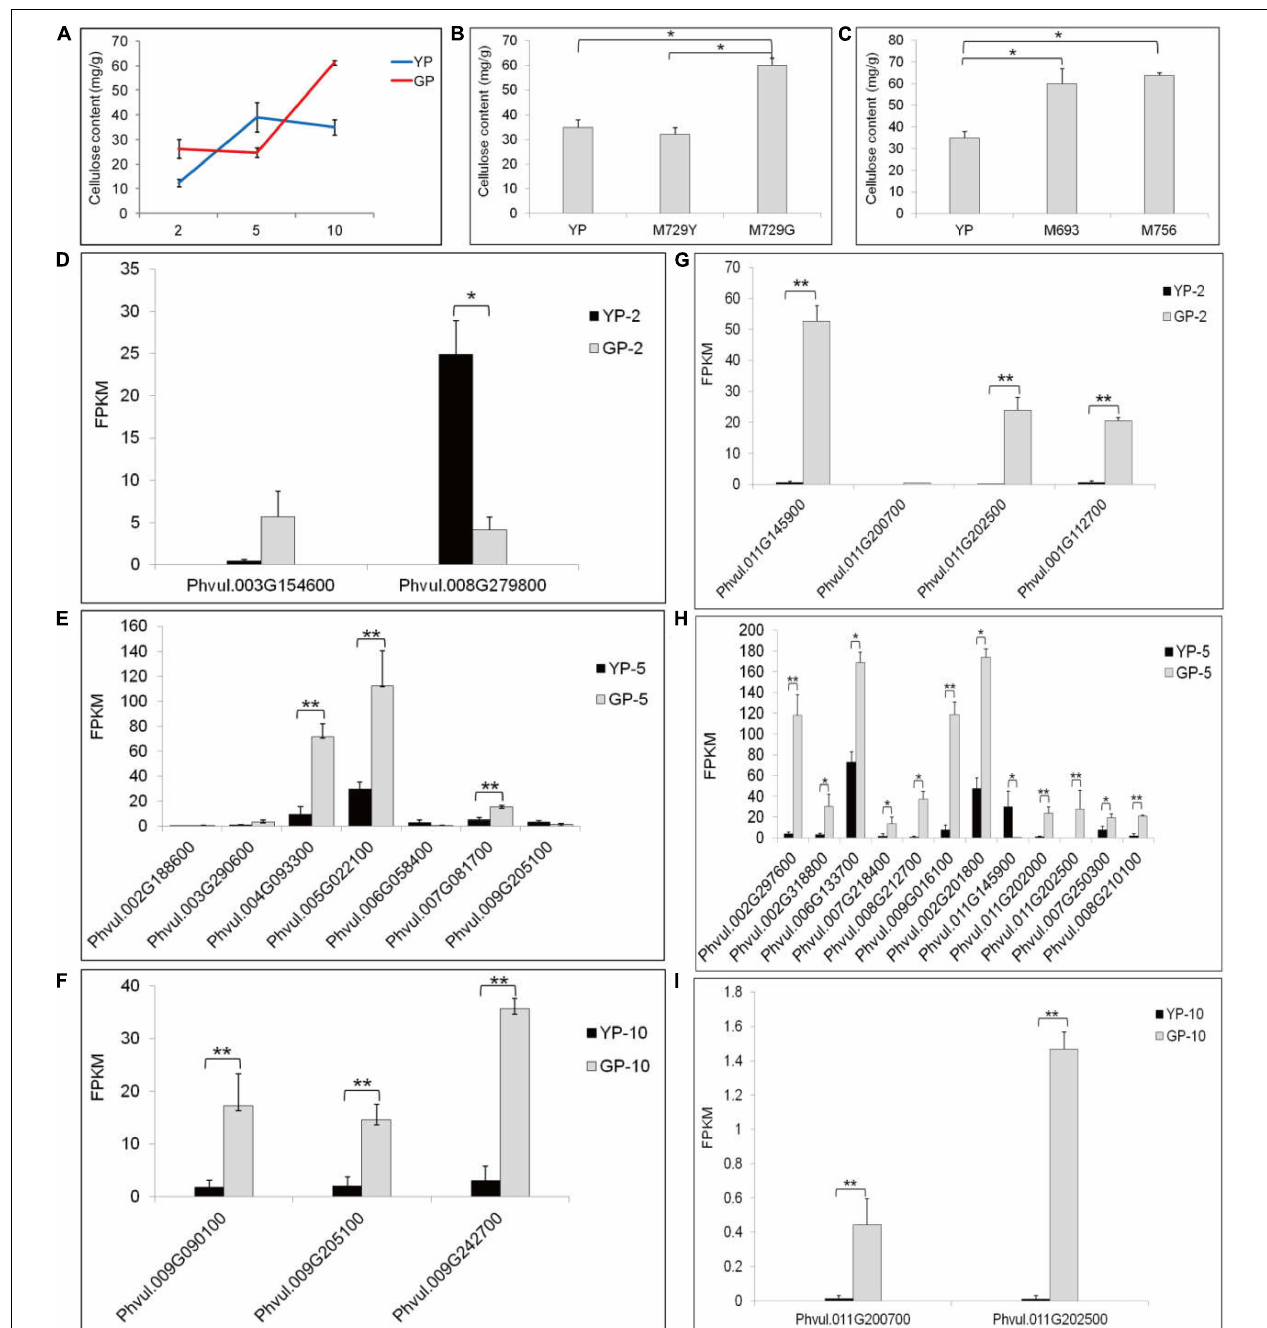
FIGURE 4 | The cellulose content and the differential expression genes analysis in starch and sucrose metabolism pathway of YP and GP. (A) The cellulose content of wild type and green pod mutant. (B,C) The cellulose content in the other green pod mutant lines, (B) M729Y and M729G and (C) M693 and M756. (D–F) Differential expression genes for cellulose synthesis between YP-2 and GP-2, YP-5 and GP-5, and YP-10 and GP-10, respectively. Phvul.004G093300 (cellulose synthase A catalytic subunit 2, CESA2 ), Phvul.005G022100 ( CESA3 ), Phvul.002G188600 , Phvul.009G090100 and Phvul.009G242700 ( CESA4 ), Phvul.007G081700 ( CESA6 ), Phvul.003G154600 , Phvul.009G205100 ( CESA7 ), Phvul.003G290600 (cellulose synthase-like protein G2, CSLG2 ), Phvul.008G279800 , and Phvul.006G058400 (cellulose synthase-like protein E6, CSLE6 ). (G–I) Differential expression genes for cellulose degradation between YP-2 and GP-2, YP-5 and GP-5, and YP-10 and GP-10, respectively. Phvul.011G145900 , Phvul.011G200700 , Phvul.011G202500 , Phvul.001G112700 , Phvul.002G201800 , Phvul.011G145900 , Phvul.011G202000 , Phvul.011G202500 , Phvul.007G250300 , and Phvul.008G210100 (beta-glucosidase). Phvul.002G297600 , Phvul.002G318800 , Phvul.006G133700 , Phvul.007G218400 , Phvul.008G212700 , and Phvul.009G016100 (endoglucanase). Error bars represent the standard deviation of three replicates. Data were analyzed using the t -test. * p < 0.05, ** p <